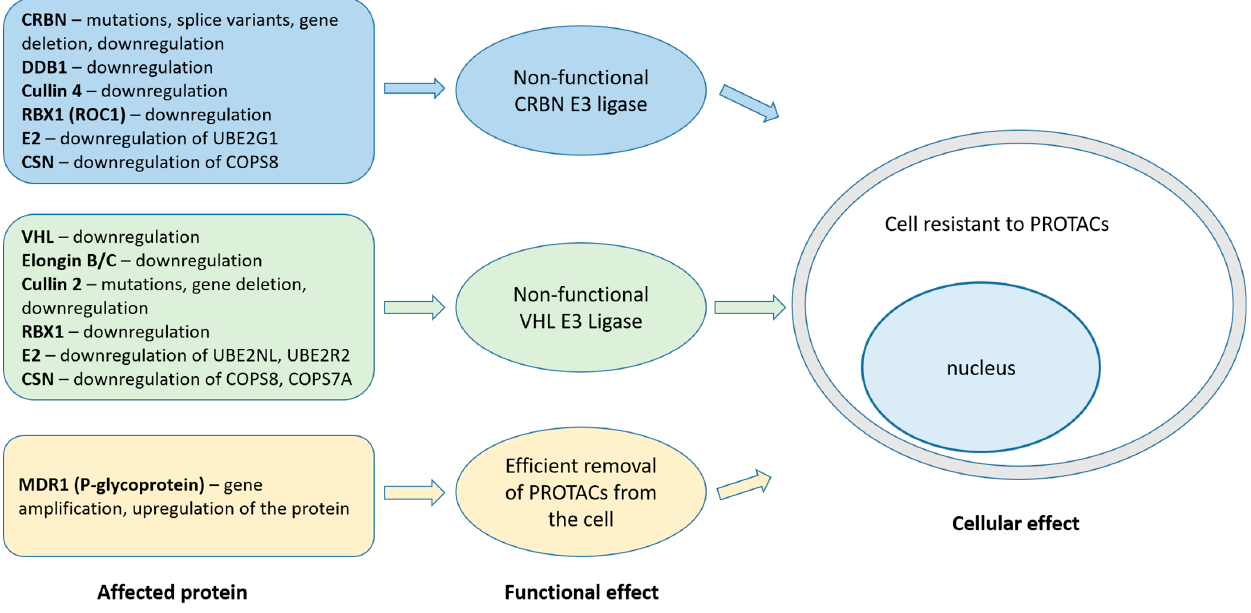
Figure 3. Possible mechanisms of resistance to CRBN- and VHL-recruiting PROTACs based on in vivo studies of patients refractory to IMiDs and in vitro studies of PROTAC-resistant cancer cells